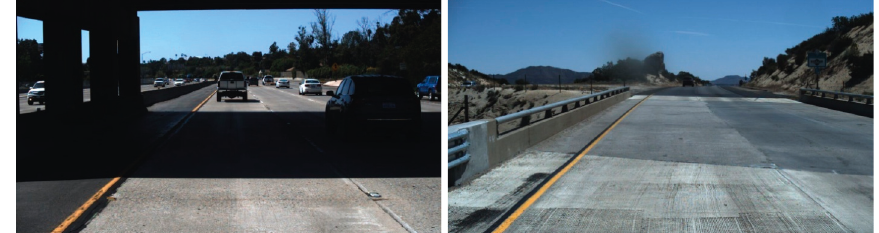
Figure 6: Results of color threshold algorithm.